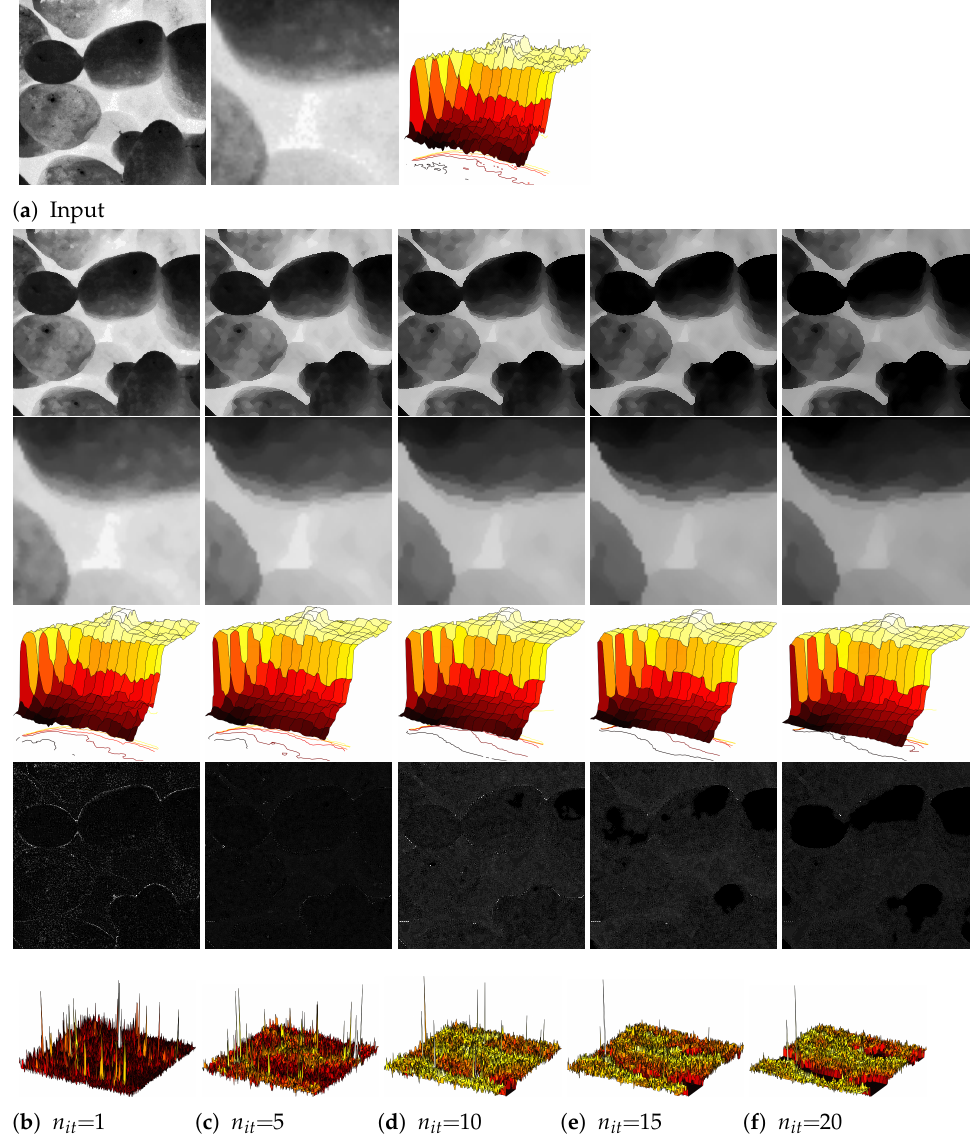
Figure 2. Scale-space representation obtained from input image ( a ), and the result from the filter for 20 iterations. The output images after 1, 5, 10, 15, and 20 iterations are presented, with a zoomed part and a height map. At the bottom, residual images are depicted with their corresponding height maps ( b – f